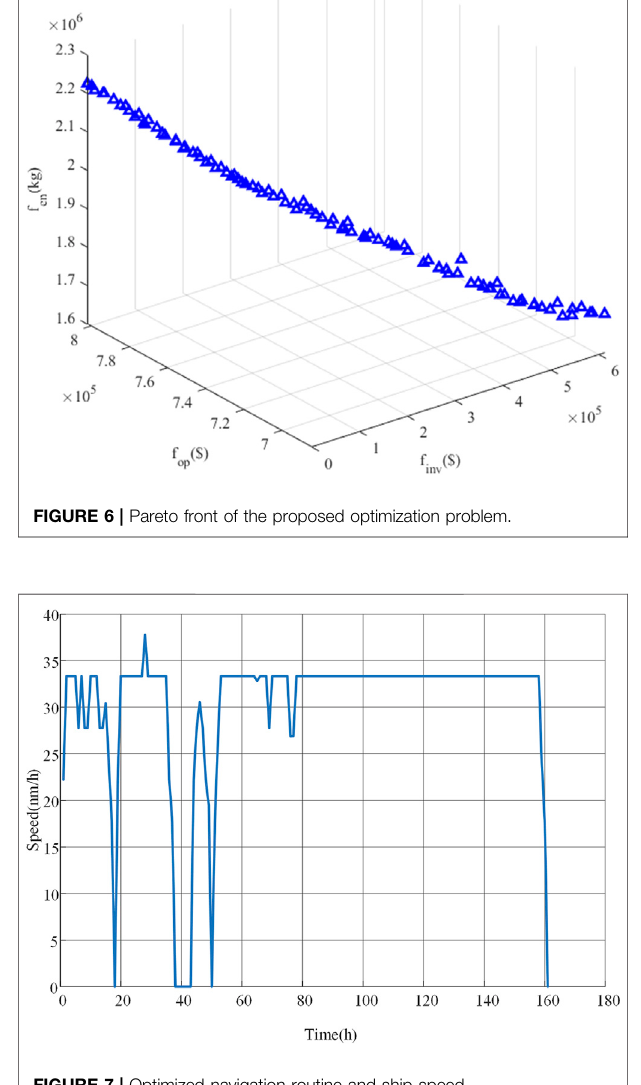
FIGURE 7 | Optimized navigation routine and ship